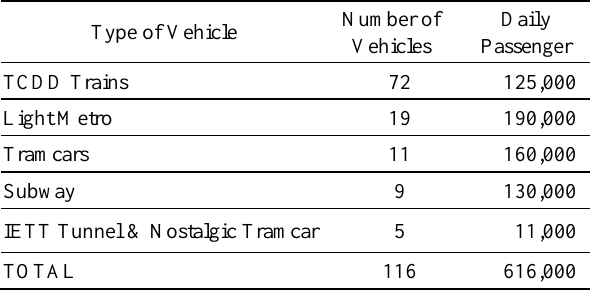
Table 2. The distribution of highway transportation.